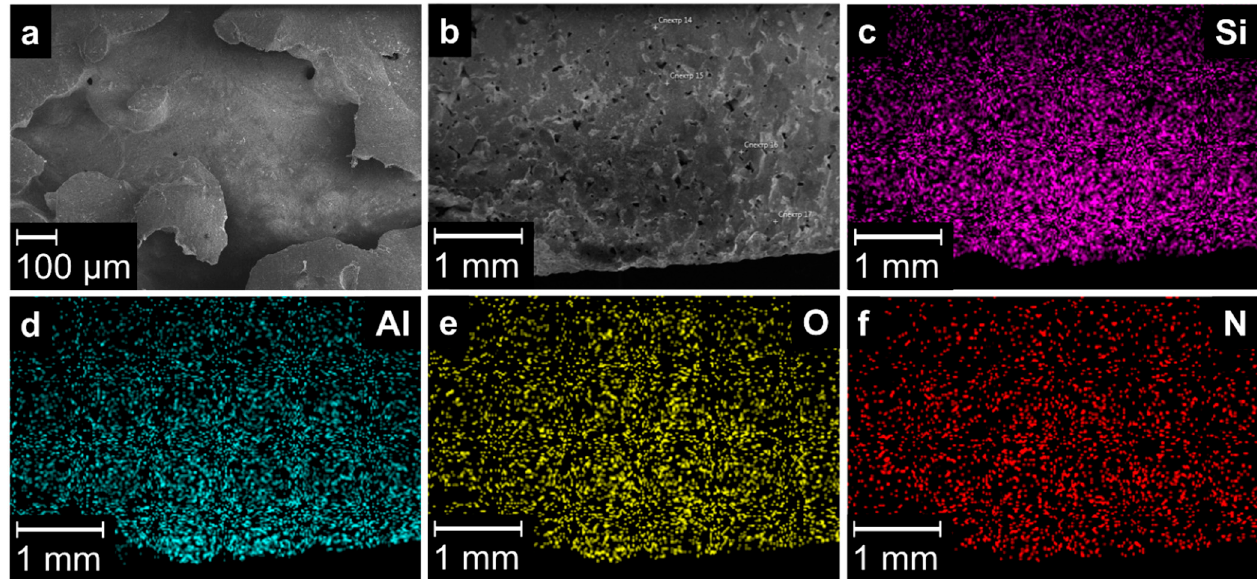
Figure 5. SEM images of the sample SiAlON-2:2.0%NaF ( a , b ) and element mapping with EDX spectroscopy ( c – f ).